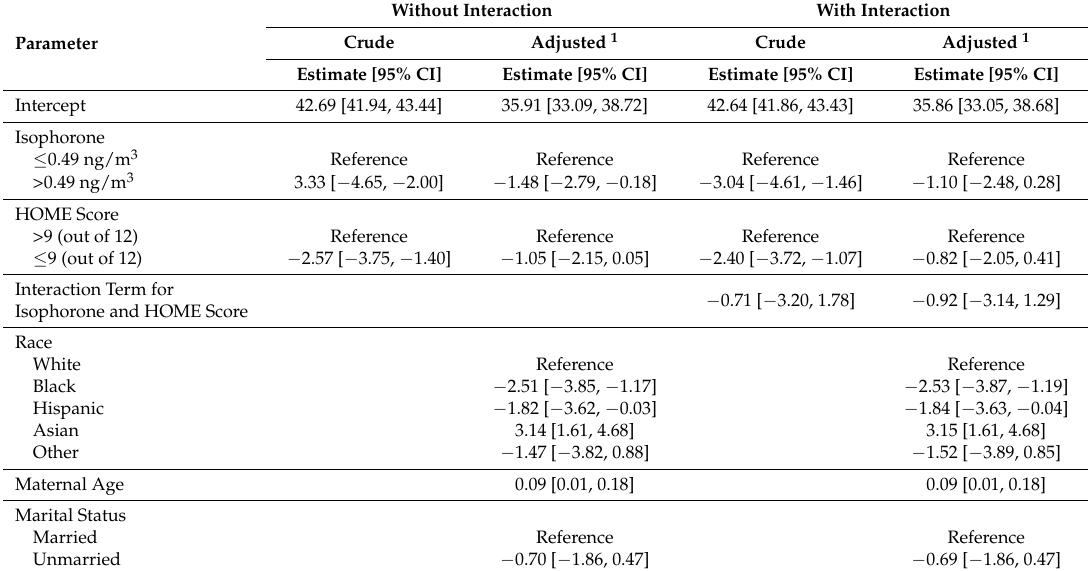
Table 4. Crude and adjusted 1 parameter estimates for associations between high isophorone exposure, low HOME score, and math scale scores among the subset of the ECLS-B 2001 birth cohort living in urban communities (N =